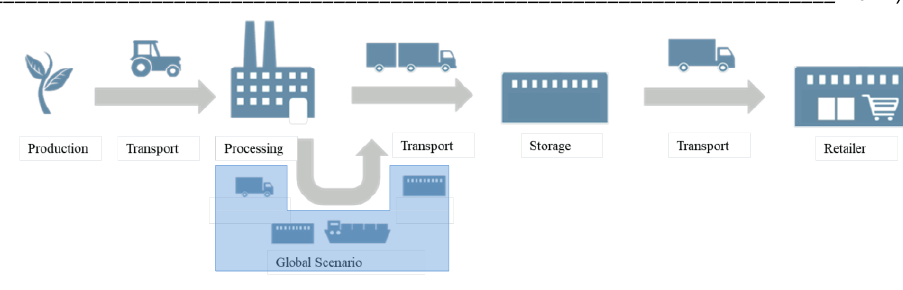
Fig. 1. The cold supply chain of food and beverage.